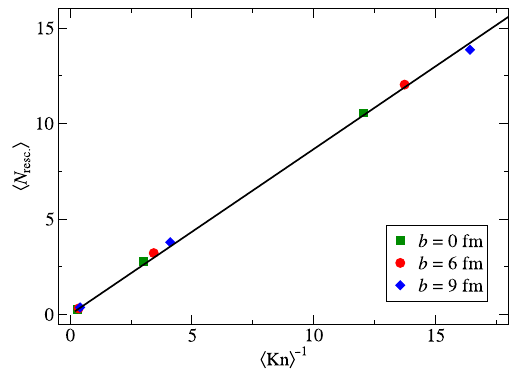
Fig. 1 Dependence of the average number of rescatterings per particle (cid:3) N (cid:4) on the inverse mean Knudsen number (cid:3) Kn (cid:4) − 1 for simulations resc. at three different impact parameters and with three different scattering cross sections. The full line is the linear fit (10)